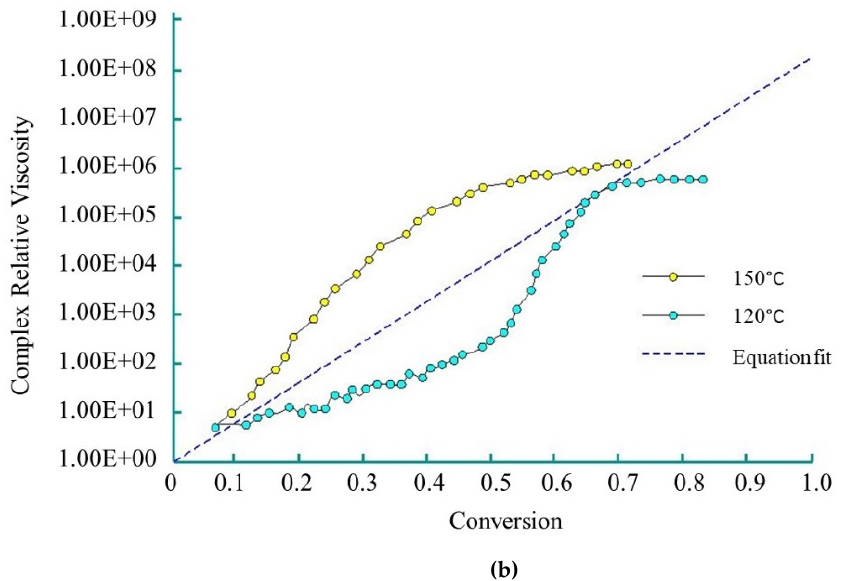
Figure 8. Complex relative viscosity ( η / η 0 ) vs. conversion for polymerization (based on references [83], reproduced with copyright permission from Elsevier, 1997): ( a ) at 120 °C, 140 °C and 160 °C; ( b ) at 120 °C and 150 °C.